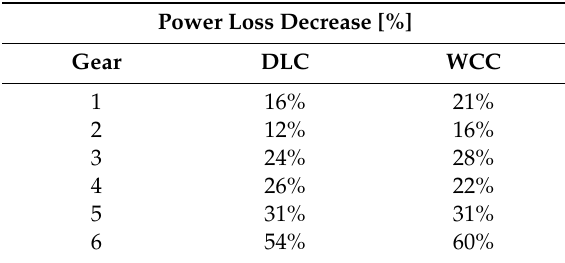
Table 8. E ff ect of coating on gear power losses.